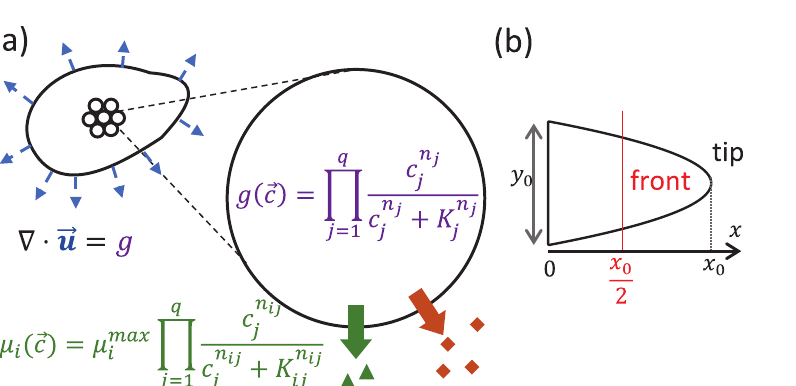
Fig 1. Schematic of the model. (a) We consider a cluster of cells, each having the potential to secrete q different diffusible chemicals. The secretion rate m ð ~ c Þ of each of these chemicals i = 1, ... , q , and the growth rate g ð ~ c Þ of each i cell depend on the local external chemical environment ~ c of the cell. Given the spatial profile of growth rate inside the cluster, we can then solve for the velocity of cell flow ~ u , which specifies how the shape of the tissue changes over time (blue arrows). (b) We initialize the system with a 2-dimensional parabolic cluster with initial length x 0 and initial width y 0